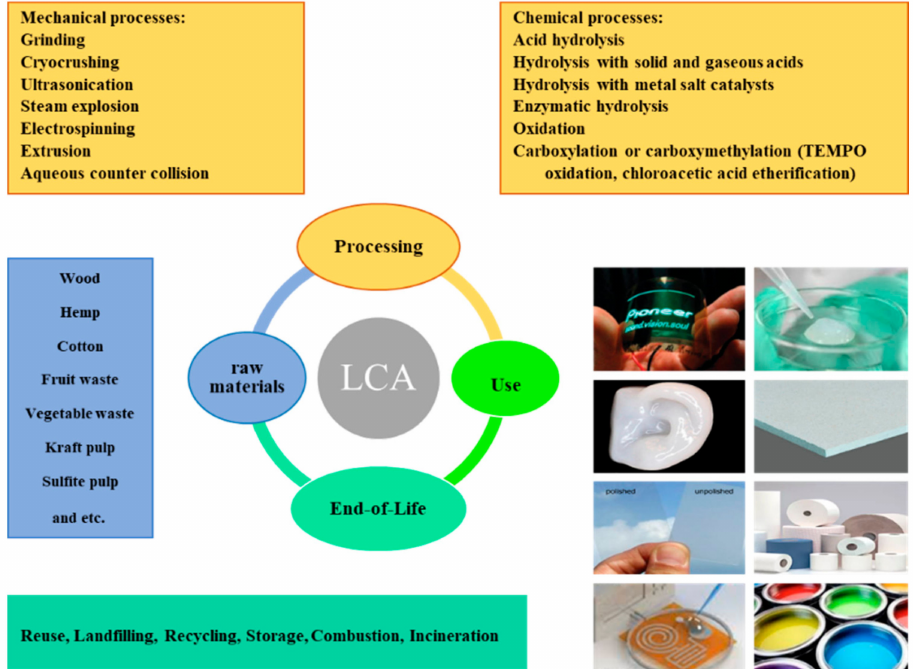
Figure 5. The life cycle of nanocellulose products, including raw materials, processing, use, and end-of-life